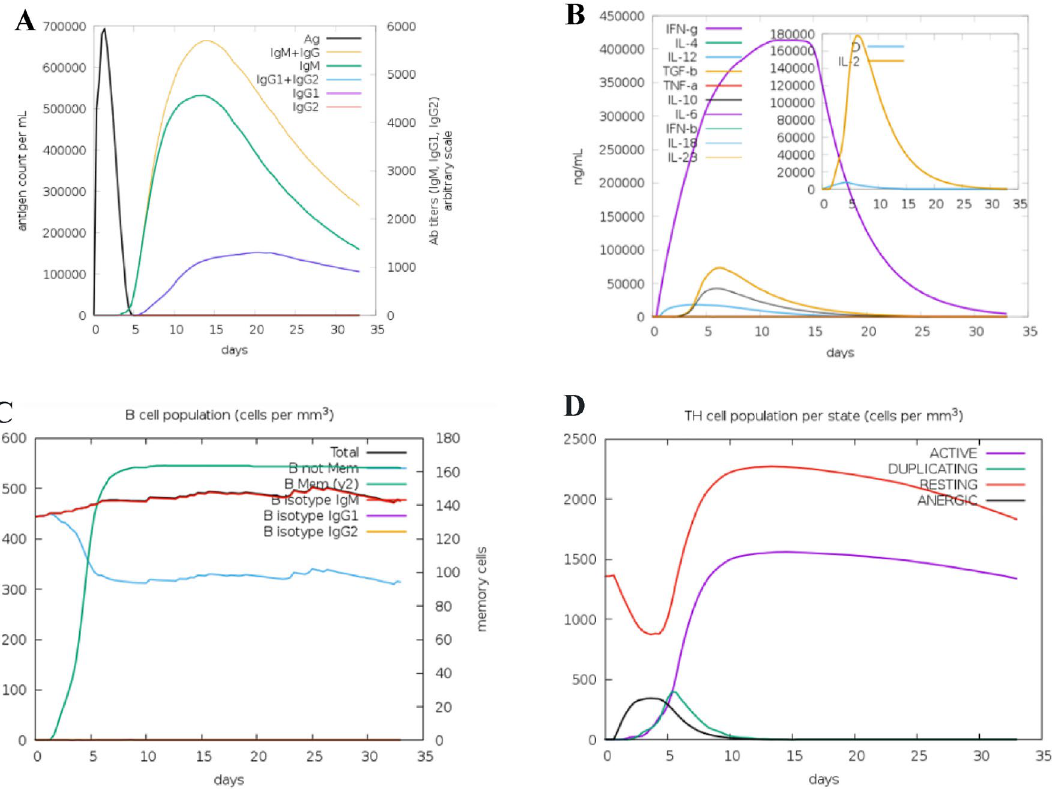
Figure 10. In silico immune simulation results of the designed vaccine from C-ImmSim server. ( A ) The titer of immunoglobulins was produced after the injection of the designed vaccine. ( B ) High titers of IFN-g and IL-2 were induced after vaccine administration. ( C ) B-cell populations prediction with a significant increase in the memory, non-memory cells, and IgM isotype. ( D ) The T-helper cell population per state (cells per mm3) levels increased after the